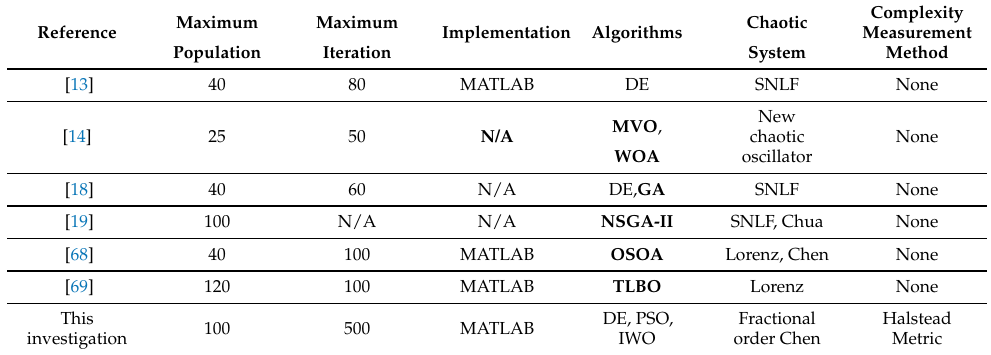
Table 4. A comparison of this investigation with some other works in chaotic behavior